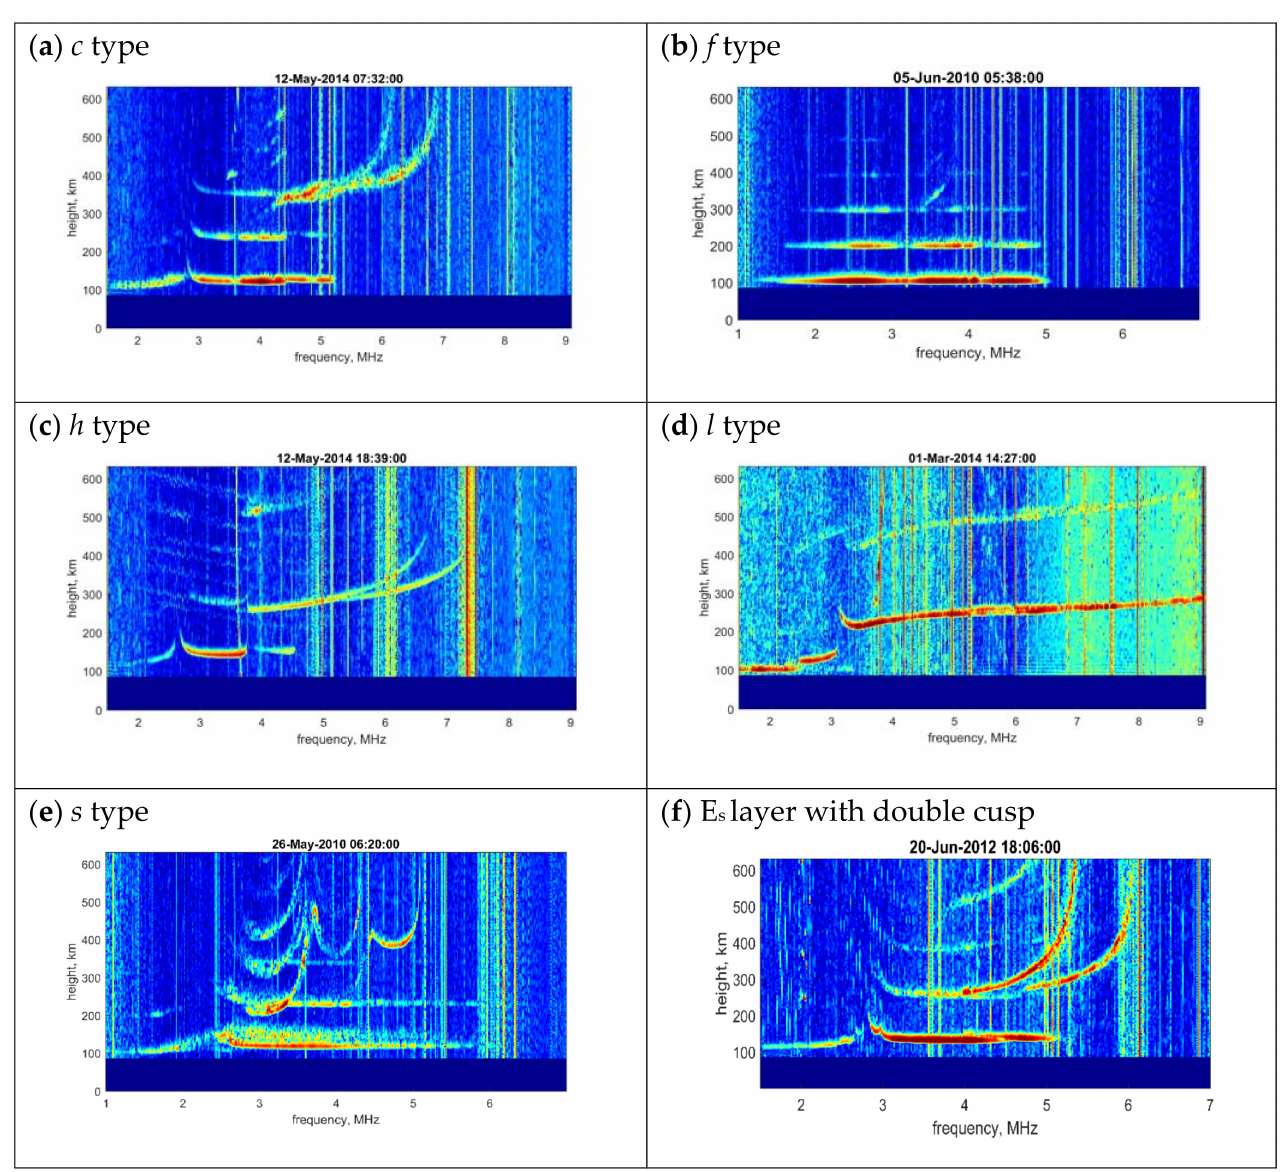
Figure 1. Examples of ionograms, with traces of E s layers of different types, obtained by Cyclone ionosonde: ( a ) c type; ( b ) f type; ( c ) h type; ( d ) l type; ( e ) s and ( f ) is type of the E s layer with double